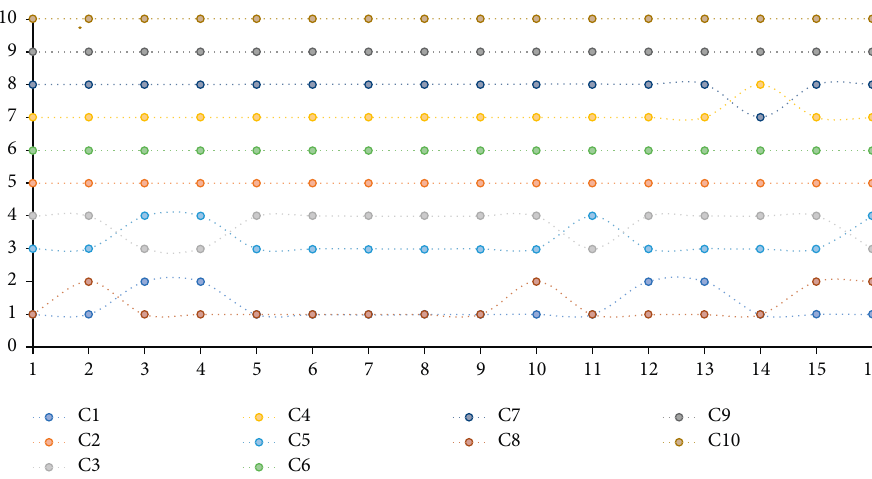
Figure 2: The 16 runs sensitivity analysis